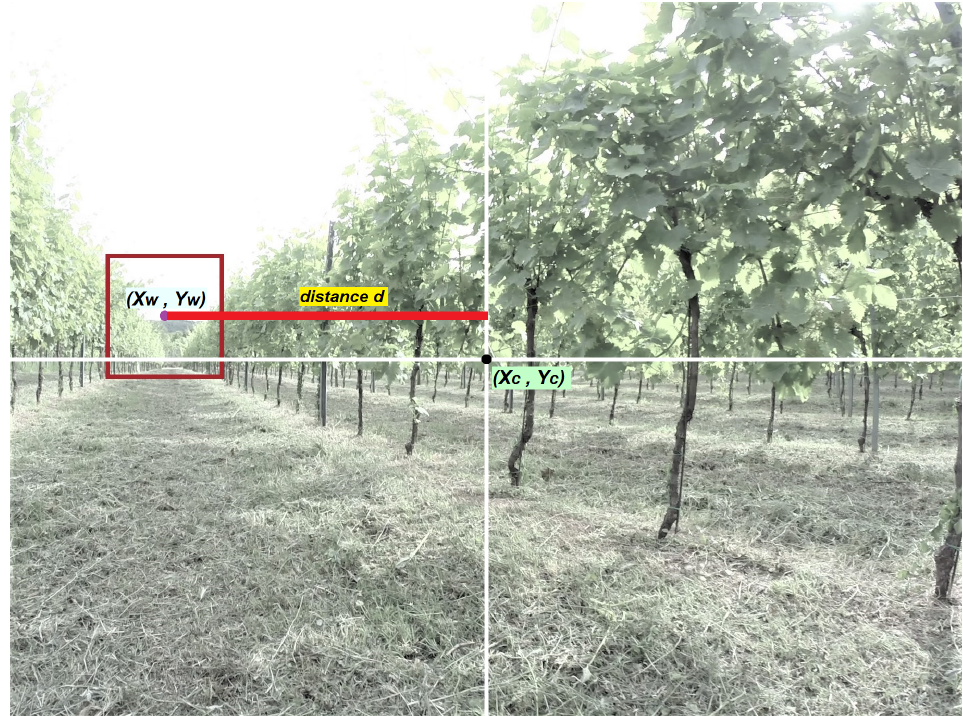
Figure 2. Depth-map algorithm scheme. The end of the vineyard row detected is represented by the red rectangle. The value d , on which the control algorithm is based on, is computed as the horizontal distance between the center of the camera frame and the center of the detected